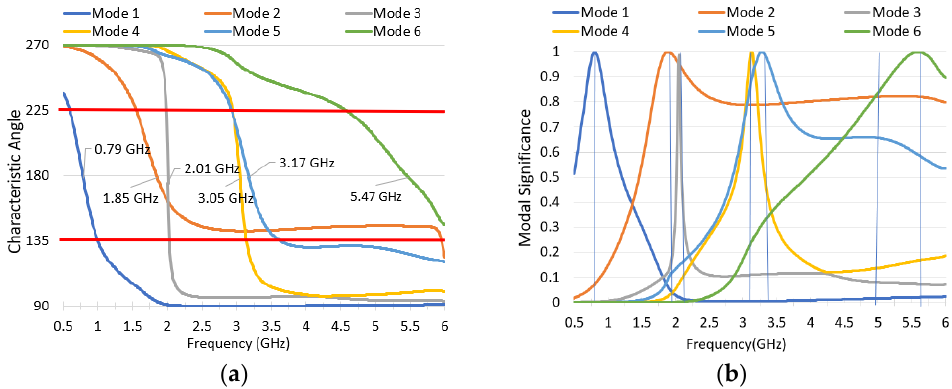
Figure 4. Characteristic mode analysis for the proposed antenna: ( a ) modal characteristic angle and ( b ) modal significance .